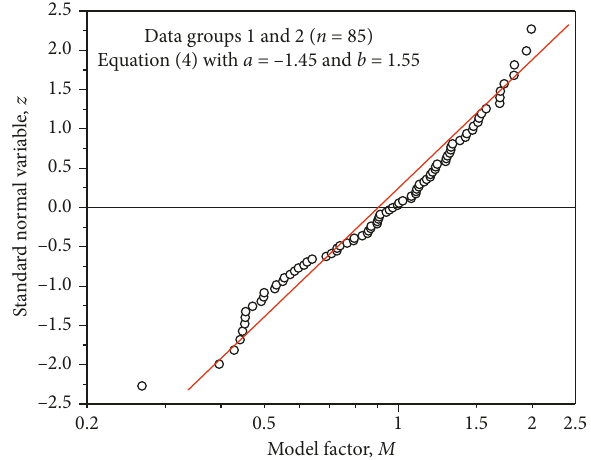
Figure 6: Cumulative distribution function plots of model factor of Equation (4) using all nail load data ( a